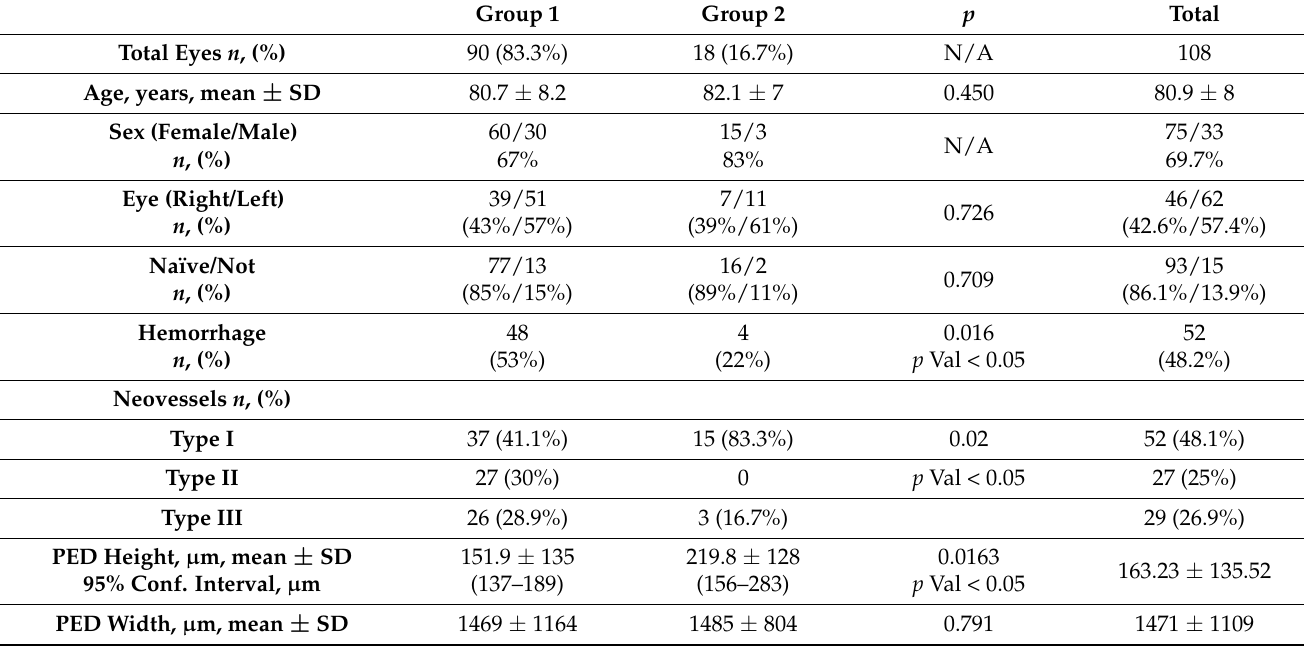
Table 1. Comparison of the demographic characteristics, SD-OCT and OCTA findings in both false negative and control